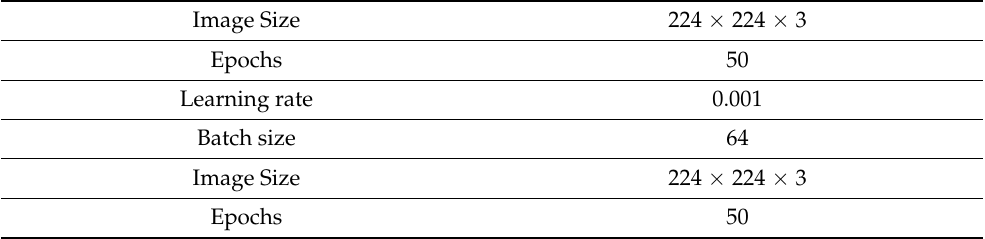
Table 2. Learning parameter settings of the CFNN.